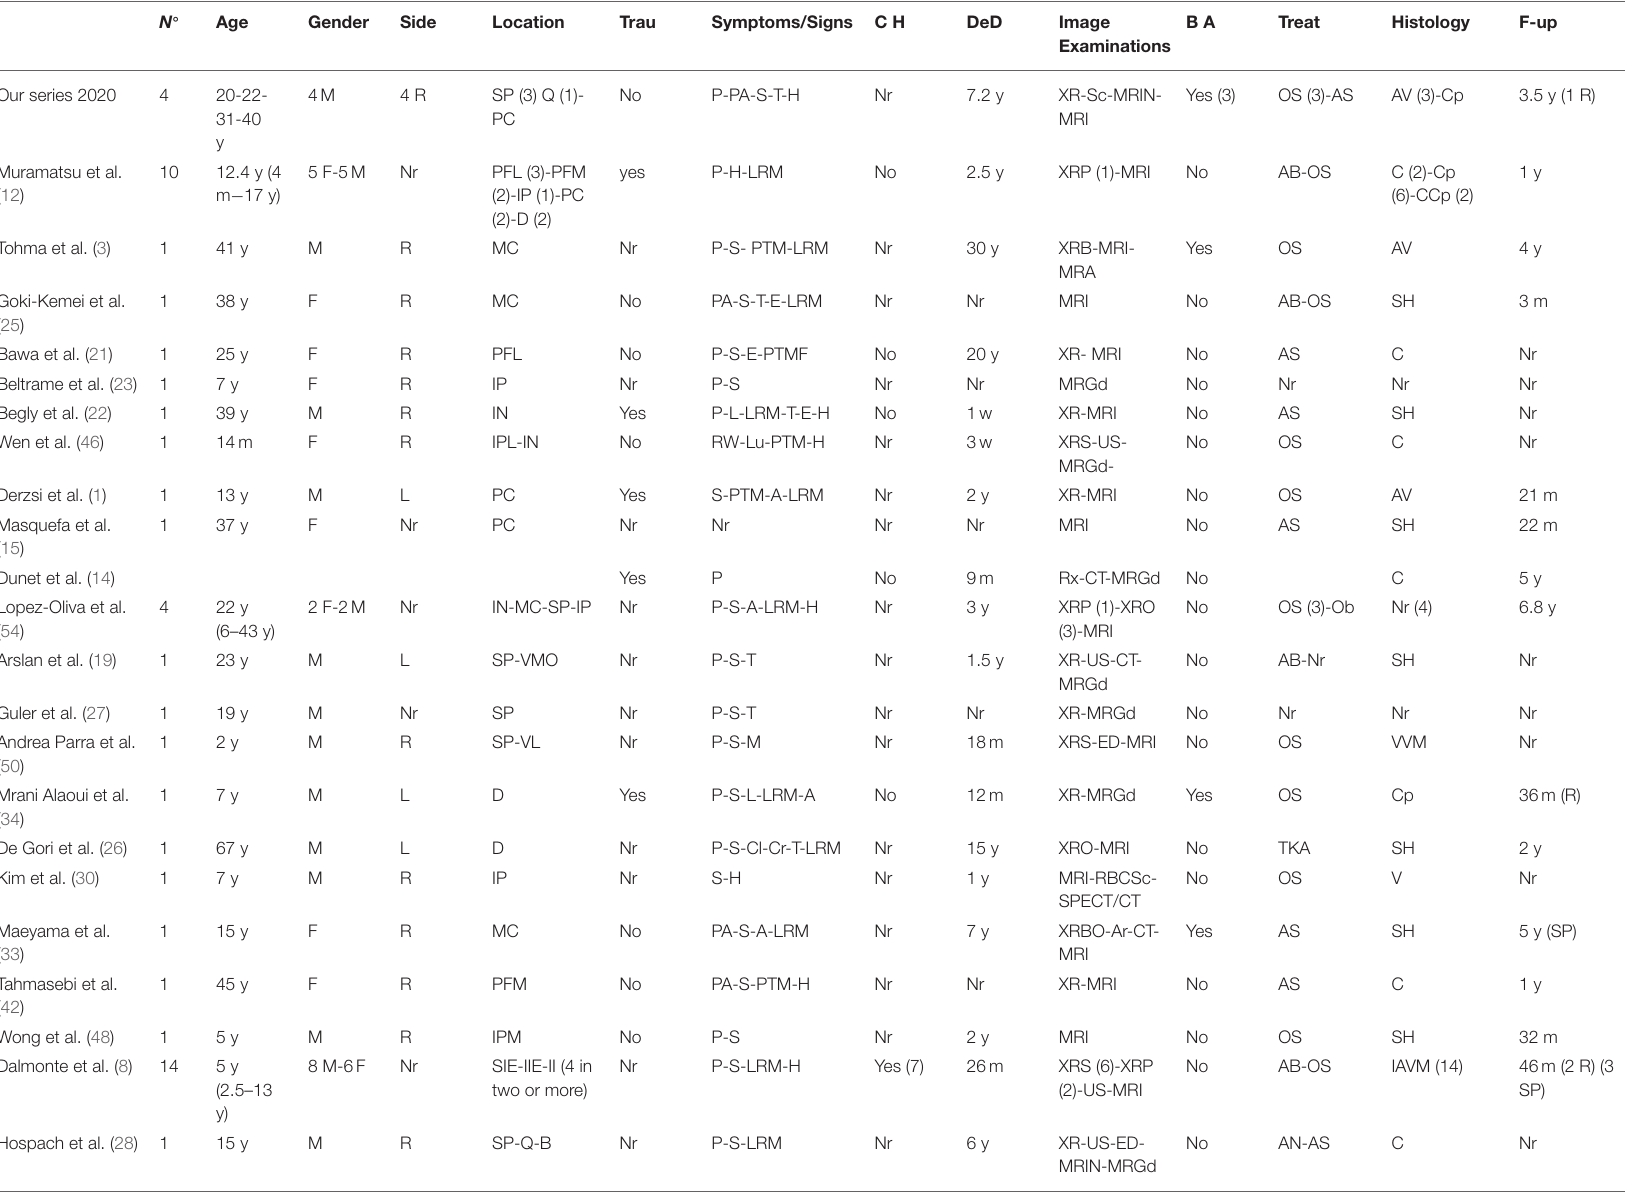
TABLE 2 | Knee synovial haemangioma literature review summary